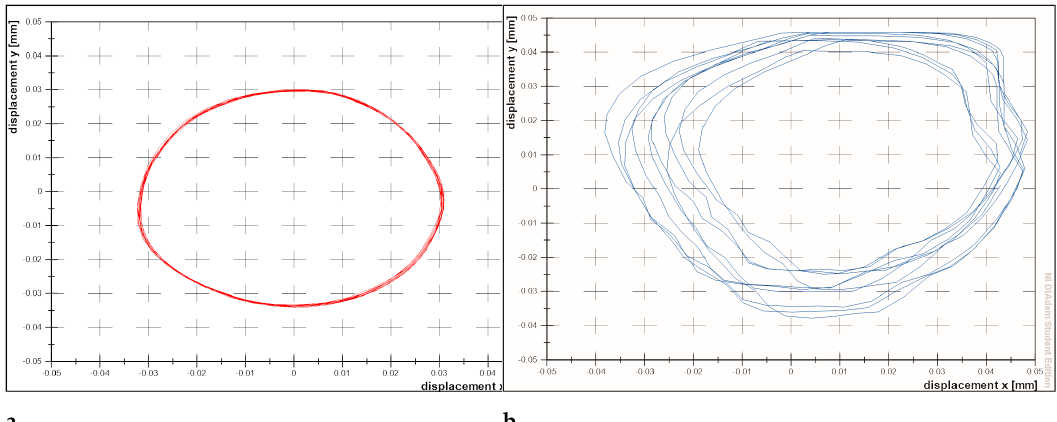
Figure 10. FTB–comparison orbital diagram coupling solutions at 40,000min −1 , driven side: turbine ( a ) torx coupling ( b ) MTD-0.2